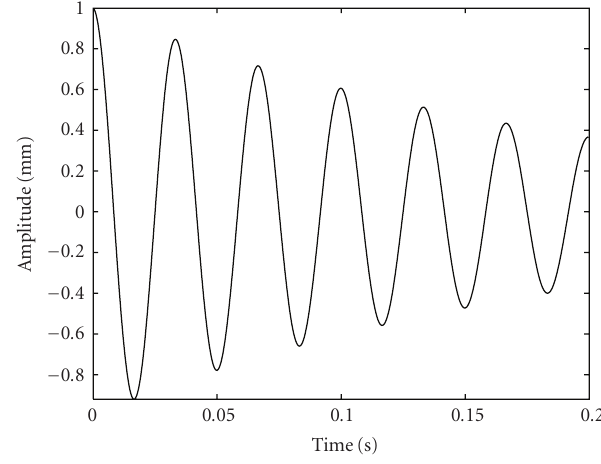
Figure 2: The monocomponent